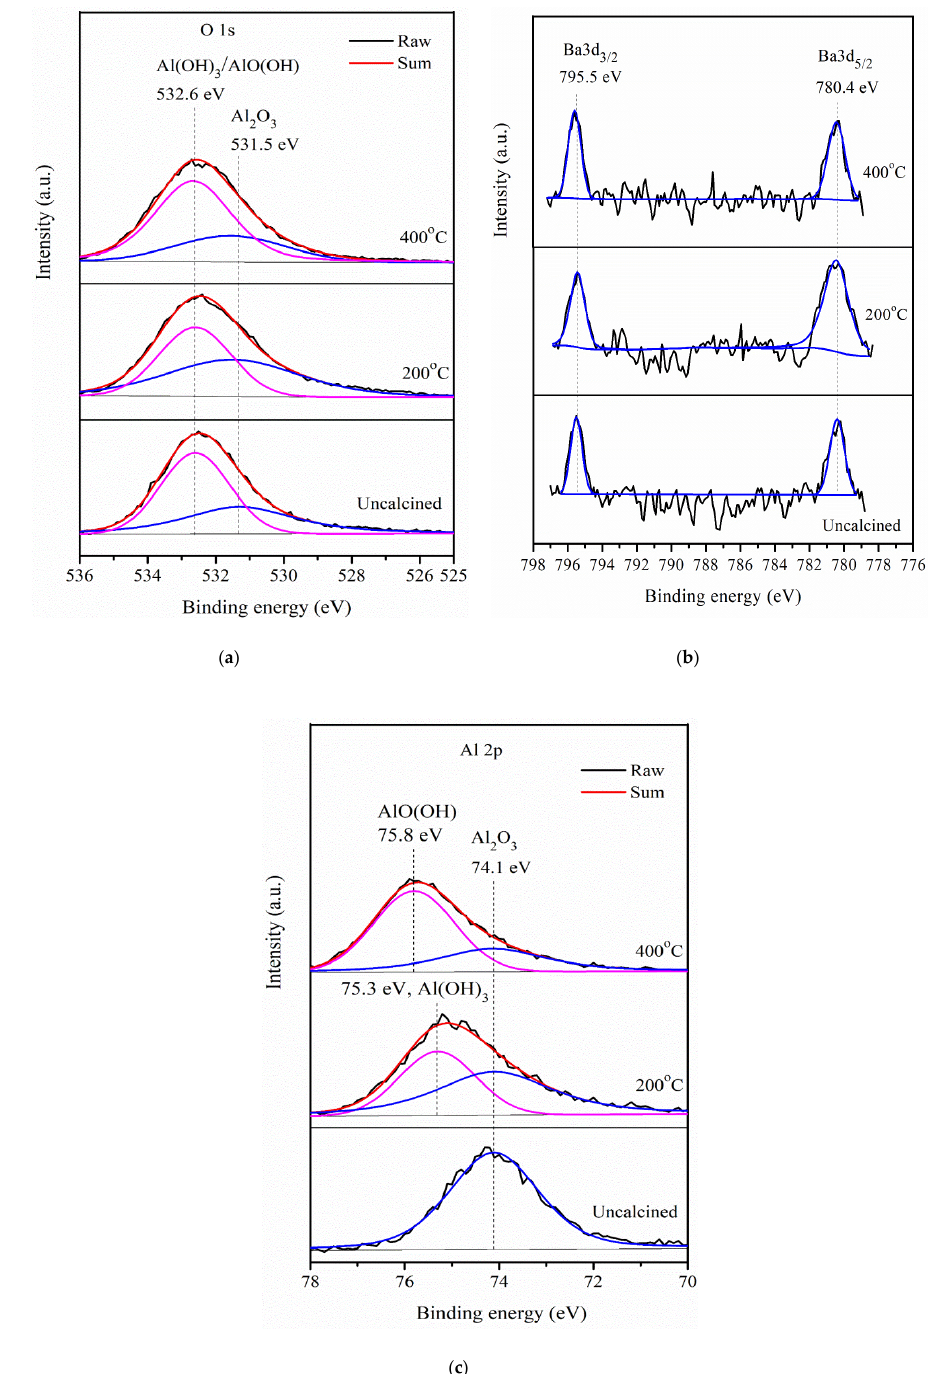
Figure 4. ( a ) O 1s ( b ) Ba 3d, and ( c ) Al 2p XPS of Ba 0.5 AlO x under different calcining temperatures.